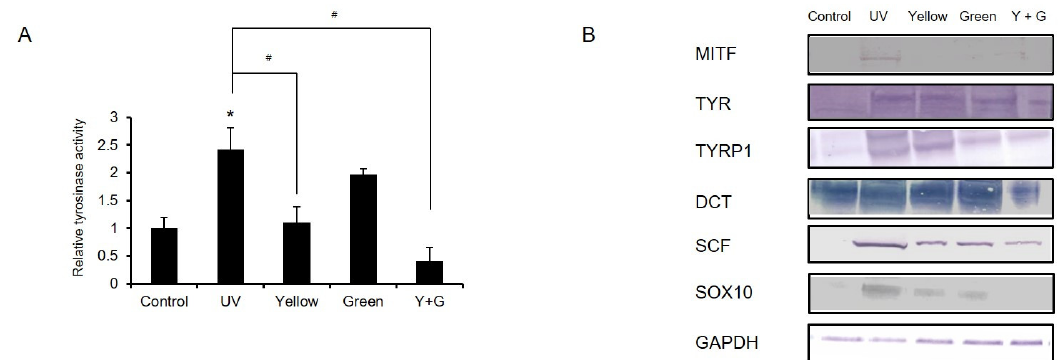
Figure 5. Anti-melanogenic effect of IPL on UVB-induced tyrosinase activity and overexpression of melanogenic proteins in human epidermal melanocytes. ( A ) The UVB-induced increased in tyrosinase activity was attenuated by yellow IPL treatment and combined yellow and green IPL treatment. ( B ) The expression of the melanogenic proteins microphthalmia-associated transcription factor (MITF), tyrosinase (TYR), tyrosinase-related protein 1 (TYRP1), dopachrome tautomerase (DCT), stem cell factor (SCF), and SRY-box transcription factor 10 (SOX10) was investigated by Western blot analysis. The full blotting data are presented in Figure S4. The results are presented as the means ± SDs of the values obtained in 3 independent experiments (N = 3). # p < 0.001 compared to the UVB-treated group; * p < 0.001 compared to the control group.